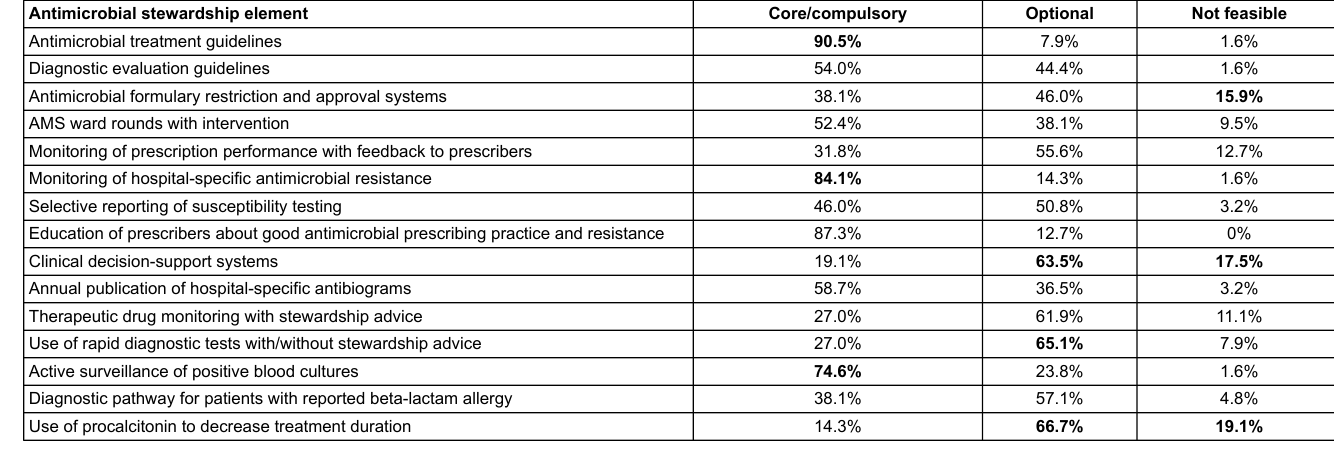
Table 2: Core and optional elements that an antimicrobial stewardship programme in Swiss hospitals should consist of according to the respondents surveyed (n = 63). Antimicrobial stewardship